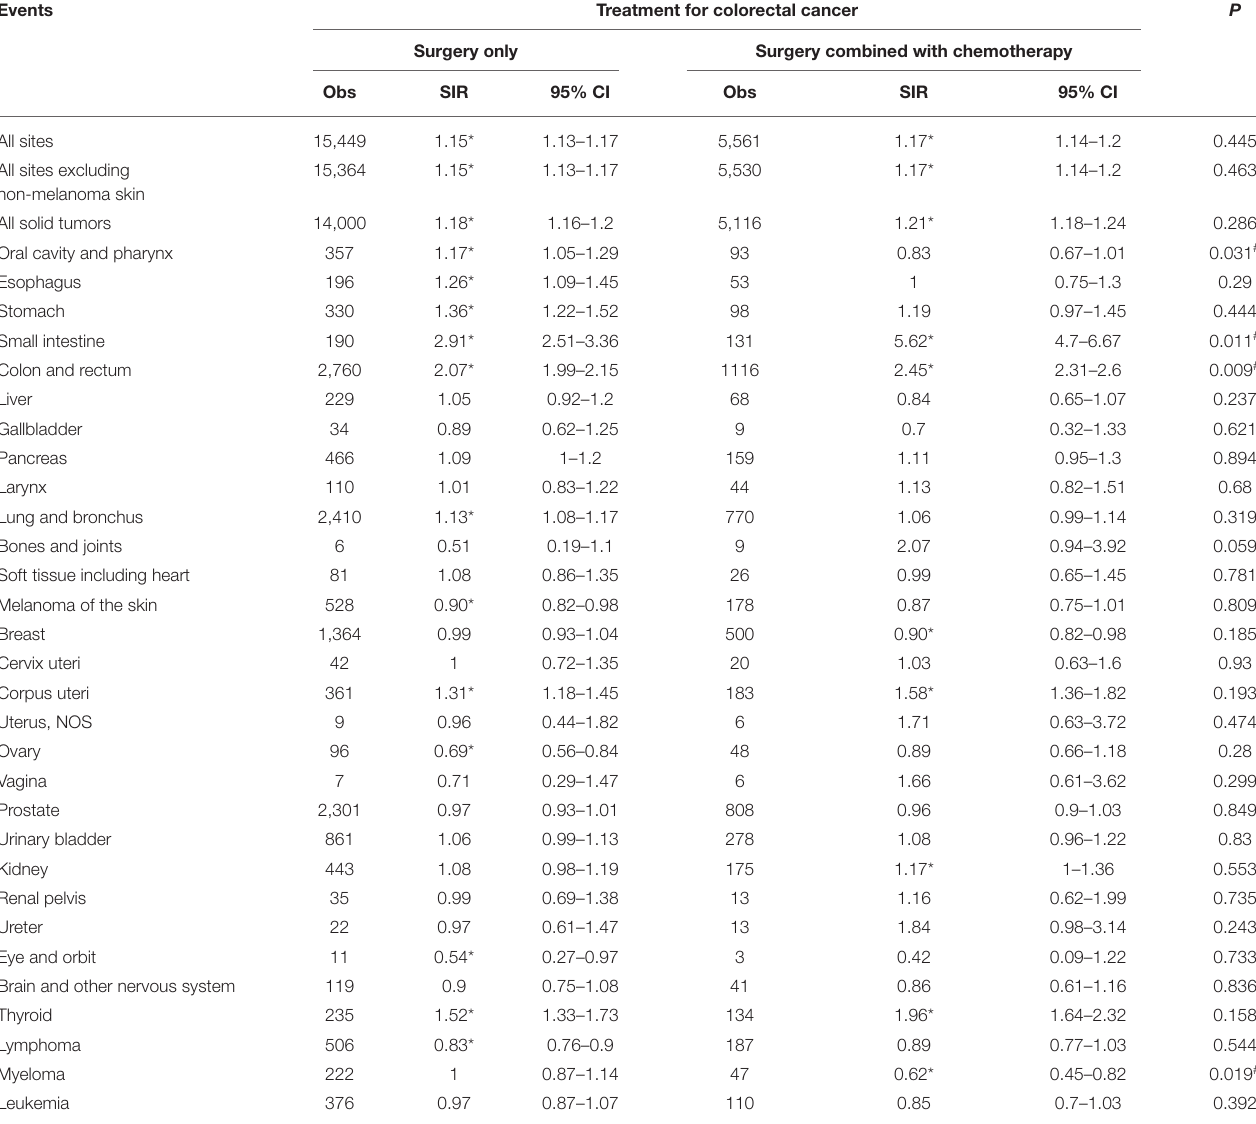
TABLE 3 | SPM risks at various anatomical sites based on previous surgery and chemotherapy treatments in colorectal CA